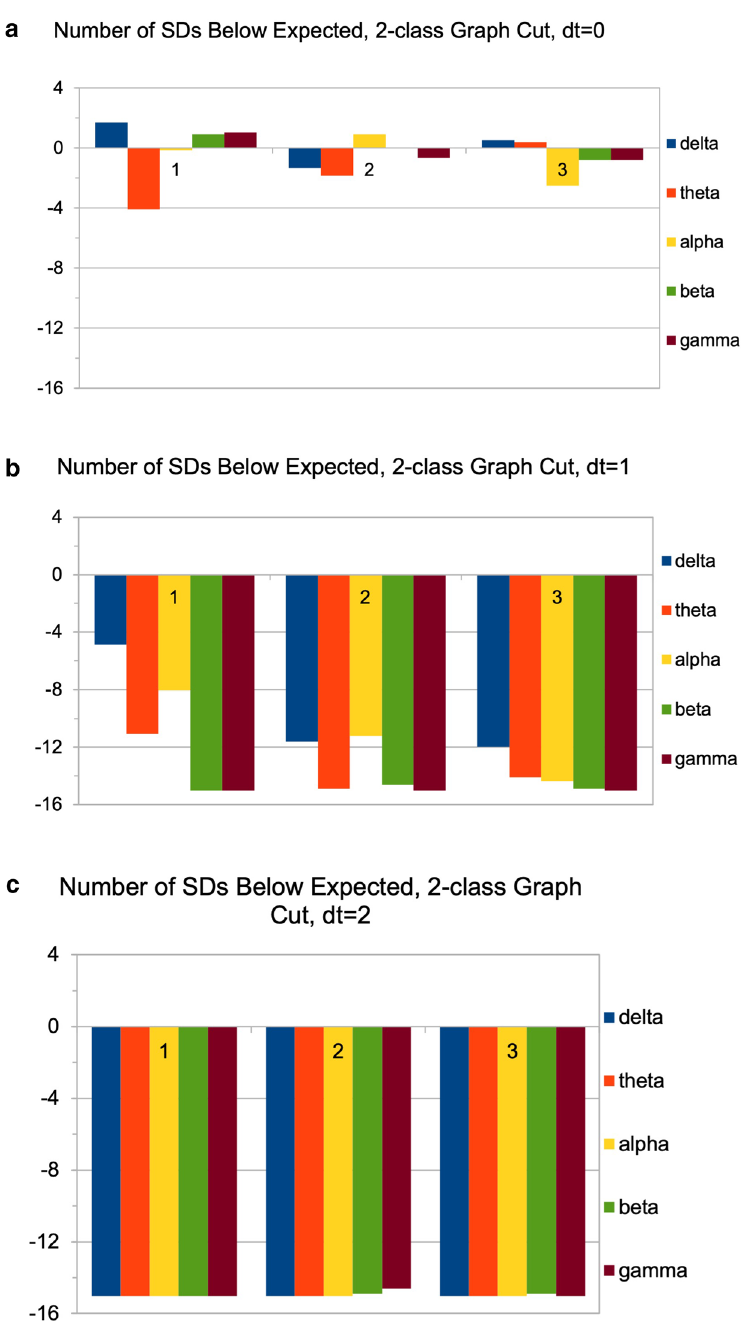
Figure 4. MVR 2-class edge-cut results, presented in terms of number of standard deviations from the null expected value. Graphs represent deviations for ( a ) dt = 0; ( b ) dt = 1; and ( c ) dt = 2. In general, all bands and all class pairings show increasingly significant deviations with increasing time-delay. Bars are grouped as follows: ‘1’ = ‘NC-MCI’; ‘2’ = ‘MCI-PDD’; and ‘3’ =